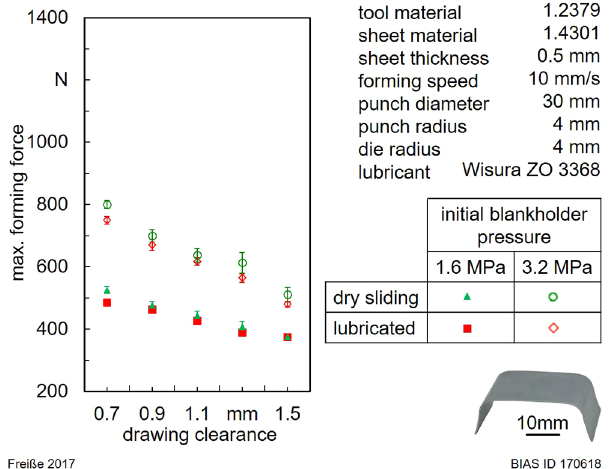
Fig. 12. Maximum forming forces using steel tool under variation of the drawing clearance.